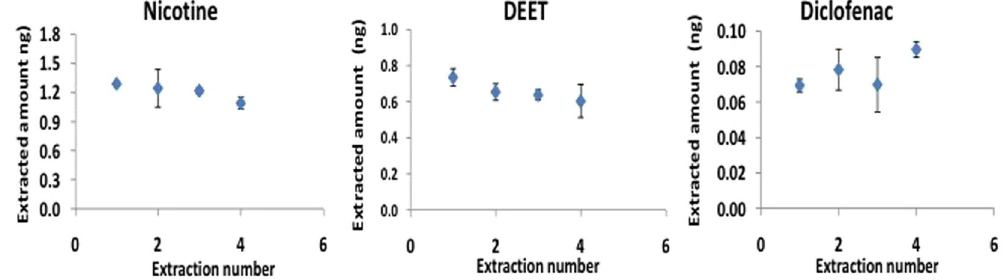
Figure 3. Repetitive extraction from 5% CS containing PBS. Extraction conditions: analyte concentration: 620 ng mL − 1 , extraction time 5 min, 30 min equilibration between extractions, desorption time 10